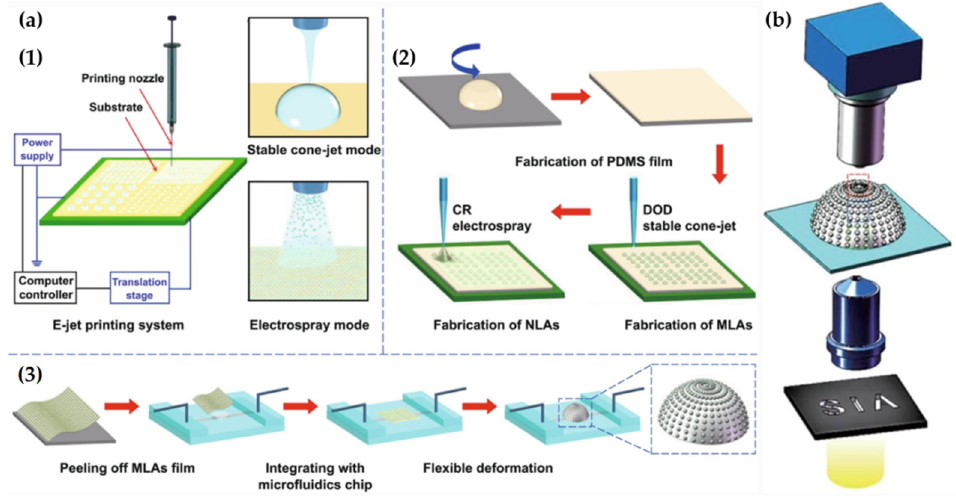
Figure 12 . ( a ) The fabrication process of curved MLA using E-Jet printing. ( b ) The structure of curved artificial compound eyes. Adapted from [46]. CC by 4.0.